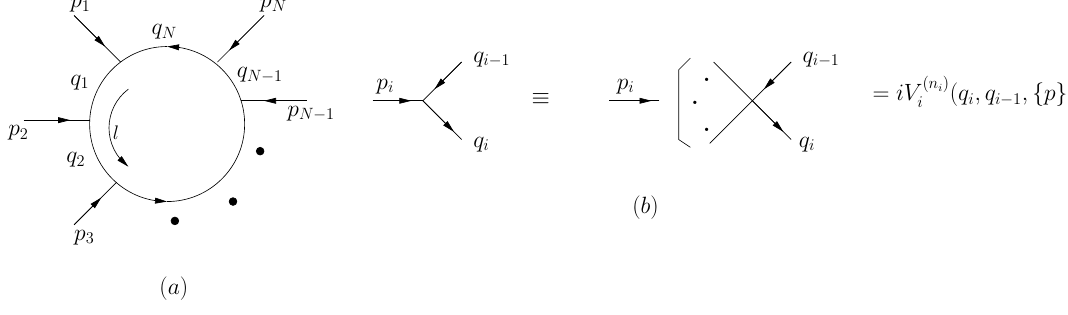
Figure 1 . (a) General 1-loop graph; (b) vertices depicted in abbreviated form as shown. taken to be incoming and anti-clockwise ordered as shown. By momentum conservation we then